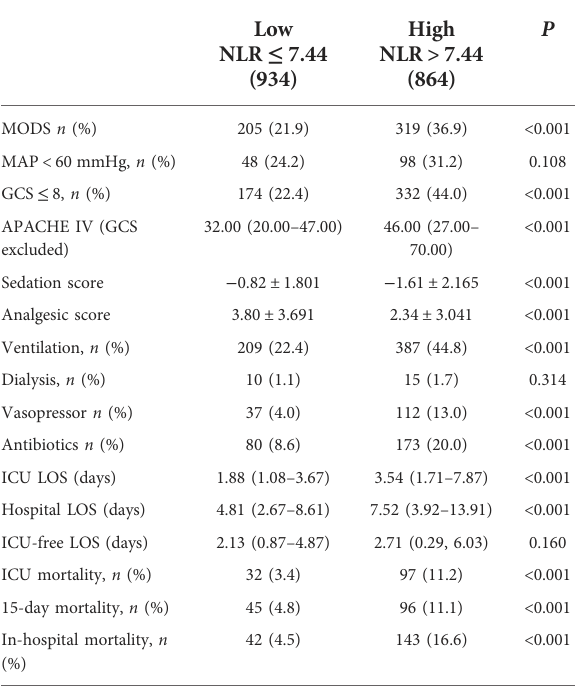
TABLE 3 Univariate analysis of baseline characteristics and main outcomes in 1,798 patients with